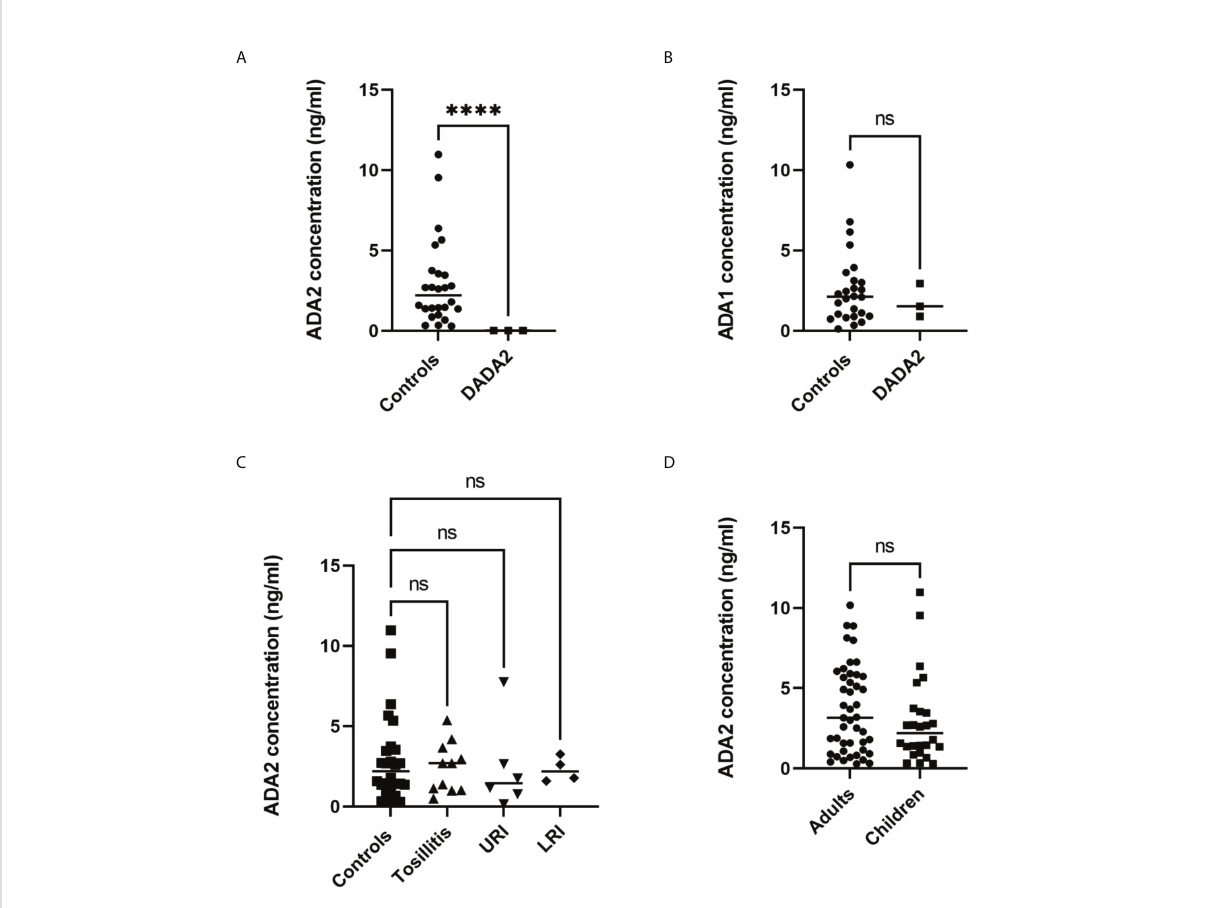
FIGURE 5 Analysis of saliva samples. (A) ADA2 concentration in saliva samples from DADA2 de fi cient children and healthy controls. ****p<0.0001 according to Welch ’ s t-test (B) ADA1 concentration in saliva samples from DADA2 de fi cient children and healthy controls. ****p<0.0001 according to unpaired t-test. (C) ADA2 concentration in saliva of healthy children, children with tonsillitis, upper respiratory infections (URI), and lower respiratory infections (LTI) (D) ADA2 concentration in saliva samples from adults and children. ****p<0.0001 according to unpaired